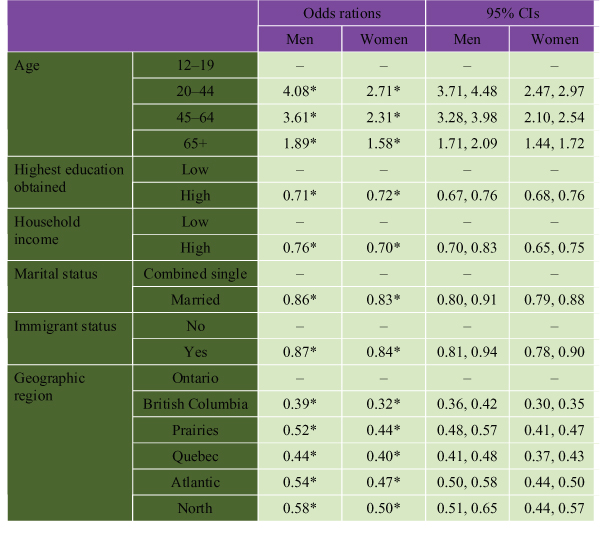
Odds of Reporting Multiple Health Risk Factors1,2 Controlling for Selected Demographic Variables. Source: Statistics Canada, CCHS, 2000–2001.1 Multiple health risk is defined as having two or more of the following health risk factors: smoking, using pain relievers, binge drinking, being physically inactive, consuming fruits and vegetables fewer than 5 times/serving per day.  2 All results were from Statistics Canada bootstrap programs.  * Outcome is with multiple risk factors.